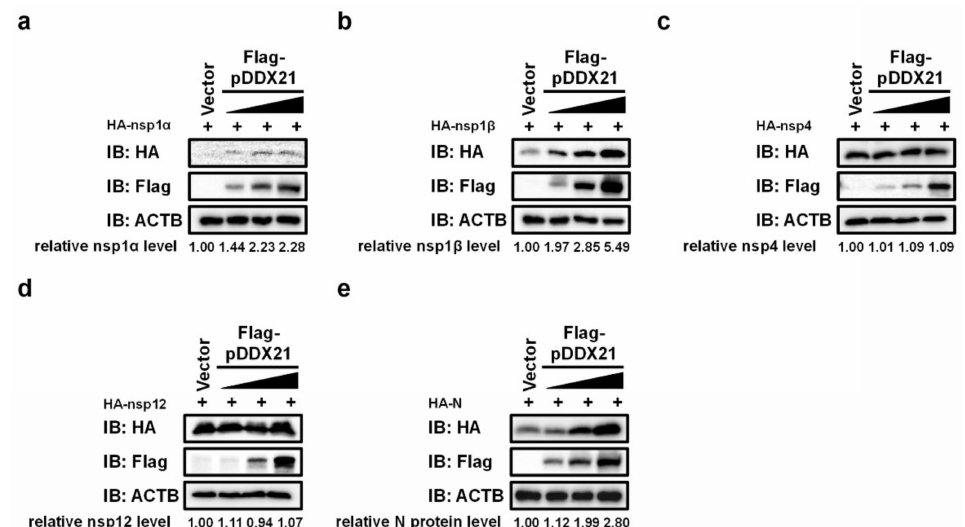
Figure 7. pDDX21 stabilizes the expression of PRRSV nsp1 α , nsp1 β , and N protein. ( a – e ) iPAM cells were co-transfected with increasing concentrations (0.5 µ g, 1.0 µ g, or 2.0 µ g) of Flag-tagged pDDX21 expression plasmid and 1.0 µ g of plasmid encoding HA-tagged nsp1 α ( a ), nsp1 β ( b ), nsp4 ( c ), nsp12 ( d ), or N protein ( e ). At 30 h post-transfection, the cells were collected for use in a Western blotting analysis with antibodies against Flag, HA, or β -actin. The relative levels of nsp1 α , nsp1 β , nsp4, nsp12, and N protein in transfected cells as compared with the levels in empty vector- transfected cells were analyzed by ImageJ software, and the resulting ratio is displayed below the images as fold change.